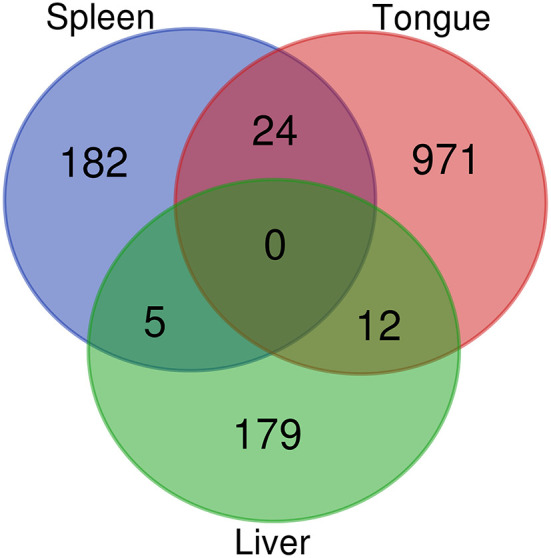
Venn diagram showing shared and unique differentially regulated transcripts among the three organs of Dicentrarchus labrax resulting from RNA sequencing (RNAseq).